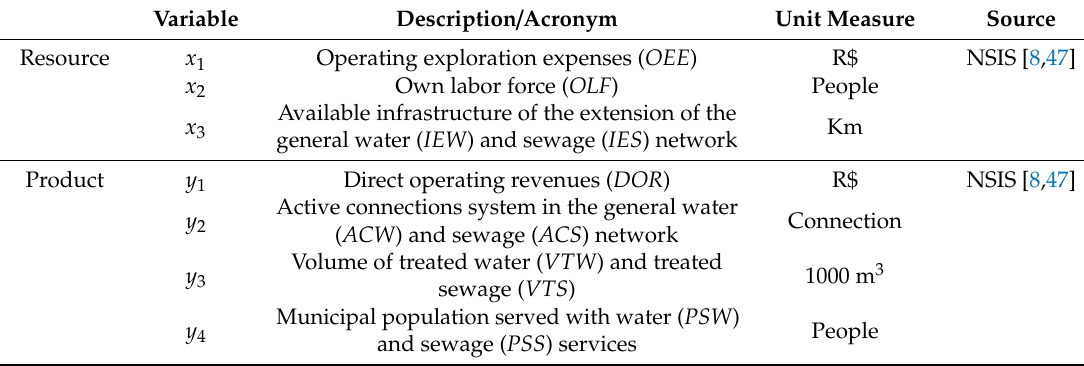
Table 2. Description of the variables used to evaluate the e ffi ciency index of the sanitation sector in